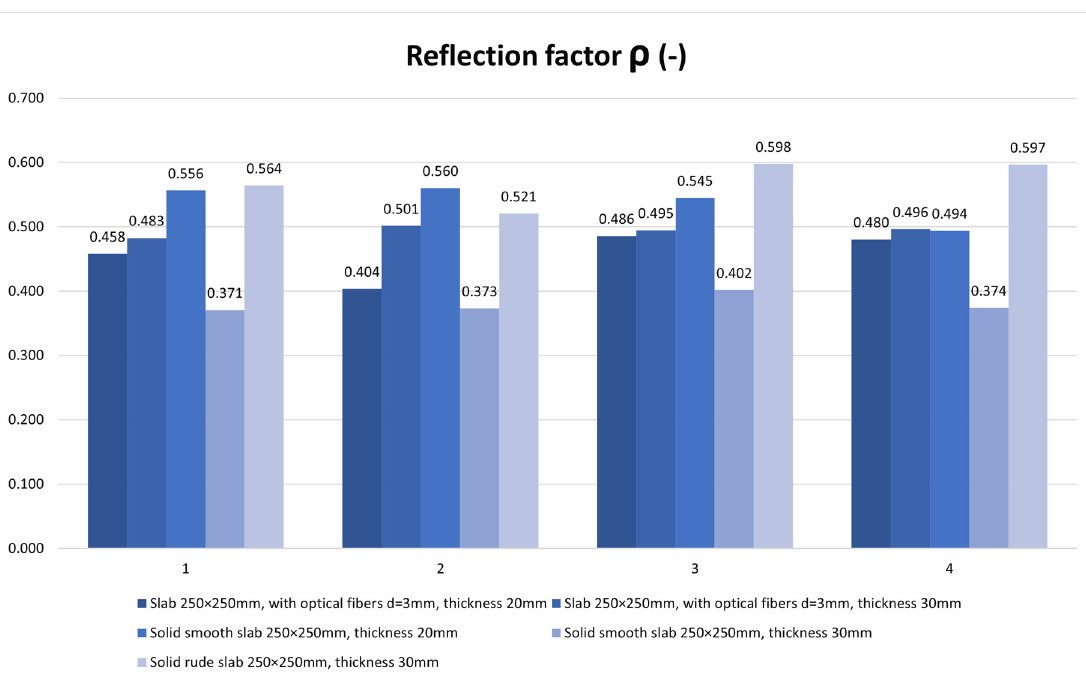
Figure 28. Reflection factor ρ